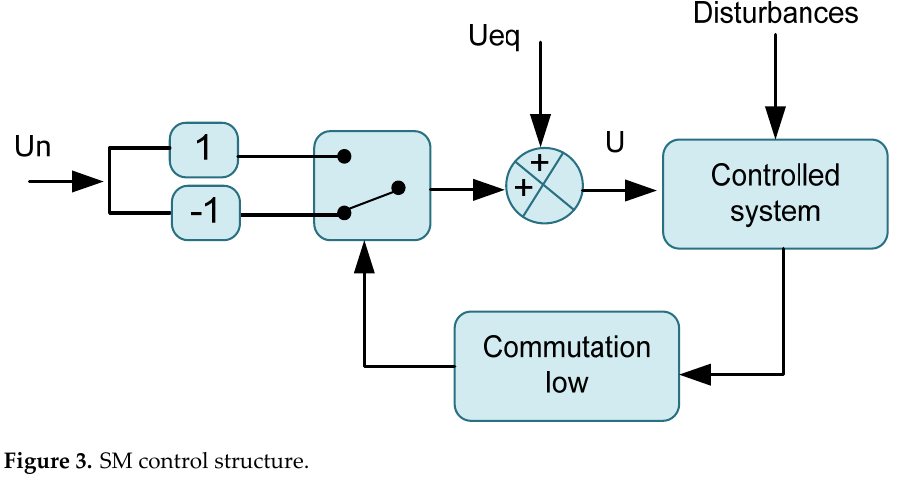
Figure 3. SM control structure.